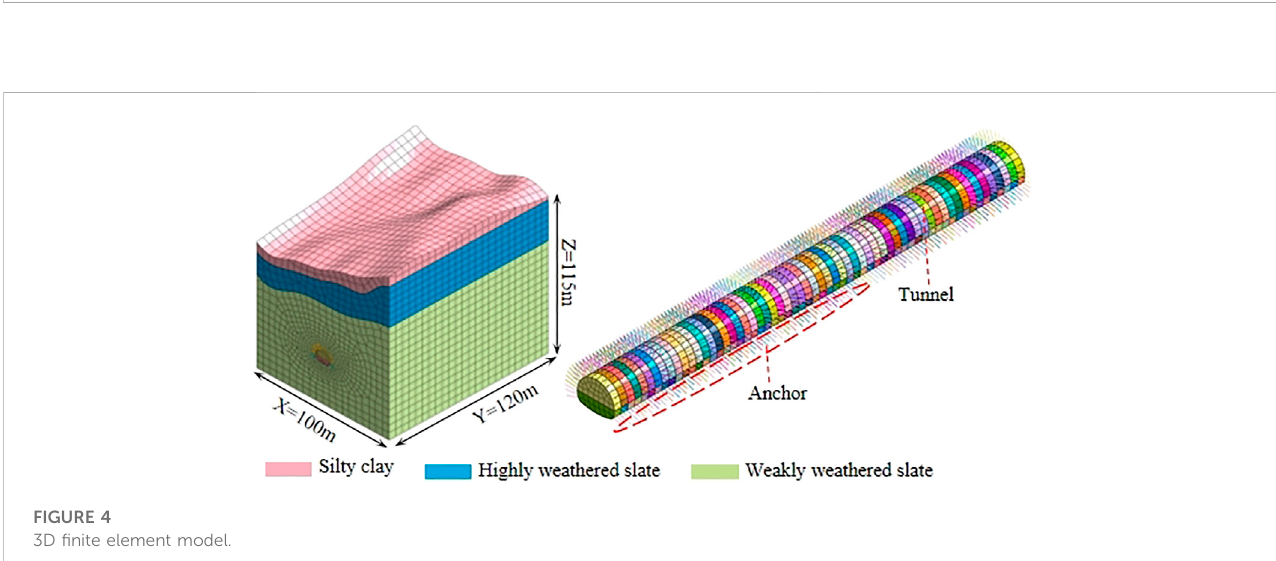
FIGURE 4 3D fi nite element